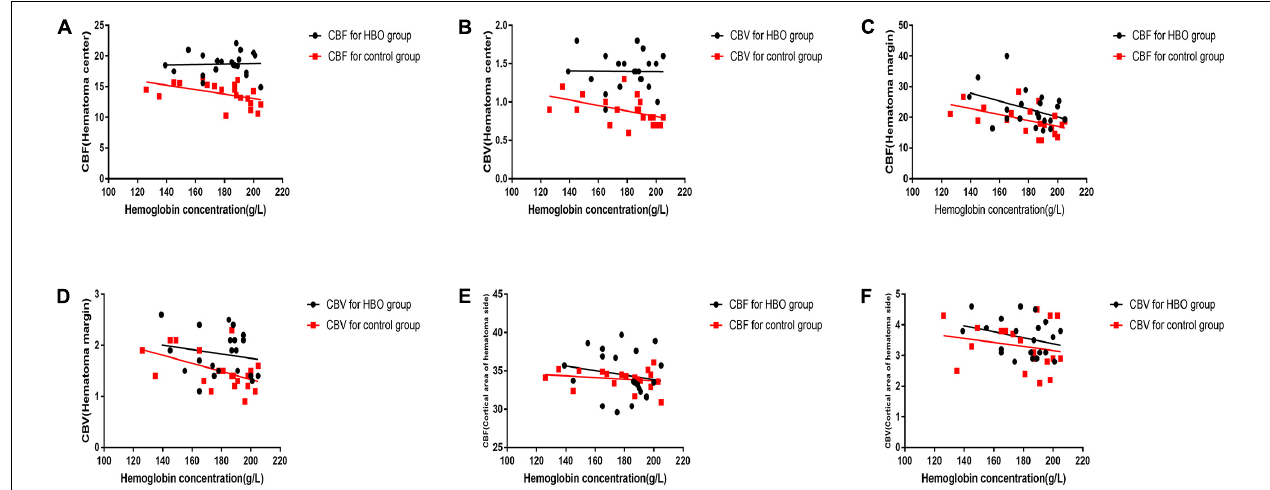
FIGURE 4 | A scatter diagram of black dots are depicted for the association between hematoma volume and the second set of CTP parameters in the HBO group. The relationship was not linear for the CBV and CBF values of the hematoma center, hematoma margin and cortical area of the hematoma (A–F) . A scatter diagram of red box are depicted for the correlation between hematoma volume and the second set of CTP parameters in the control group. The relationship was linear for the CBV and CBF values of the hematoma center (E,F) nor for the CBV and CBF values of hematoma margin (A–D) . However, no significant linear correlation was observed for the CBV and CBF values of the cortical area of the hematoma (E,F) .